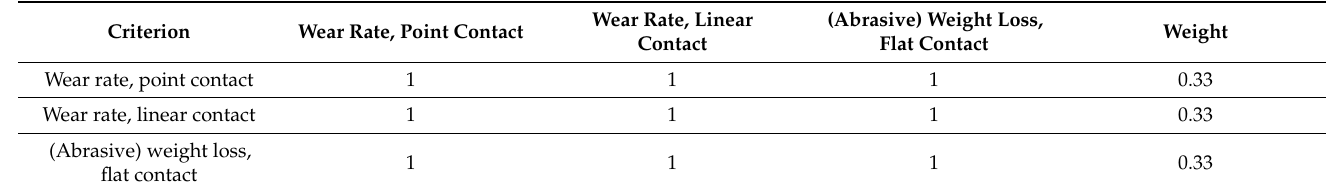
Table 11. The data on the paired comparison and the weights. Tribological factors.